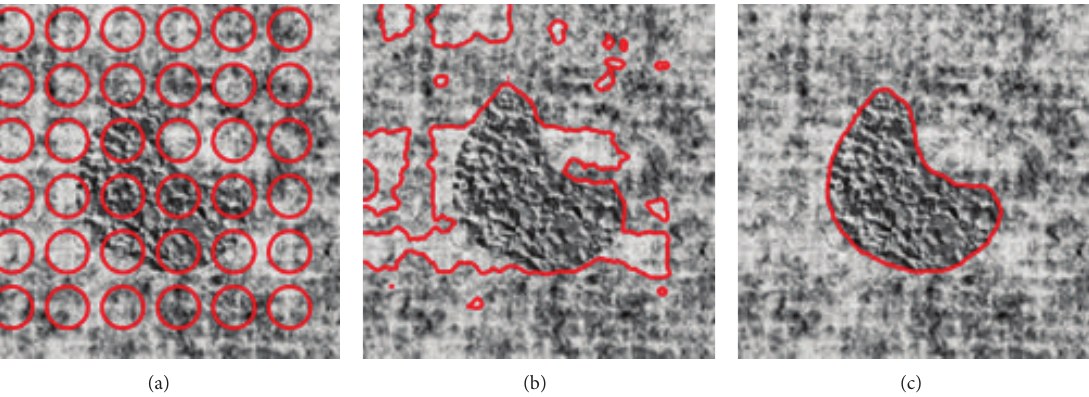
Figure 8: Segmentation results: comparison between KL-divergence-based approach and our method. (a) Original texture image and initialization of the segmentation process, (b) segmentation result with KL divergence, and (c) segmentation result with proposed approach ( 𝜉 = 1 , 𝛽 = 5 , 𝜎 = 0.1